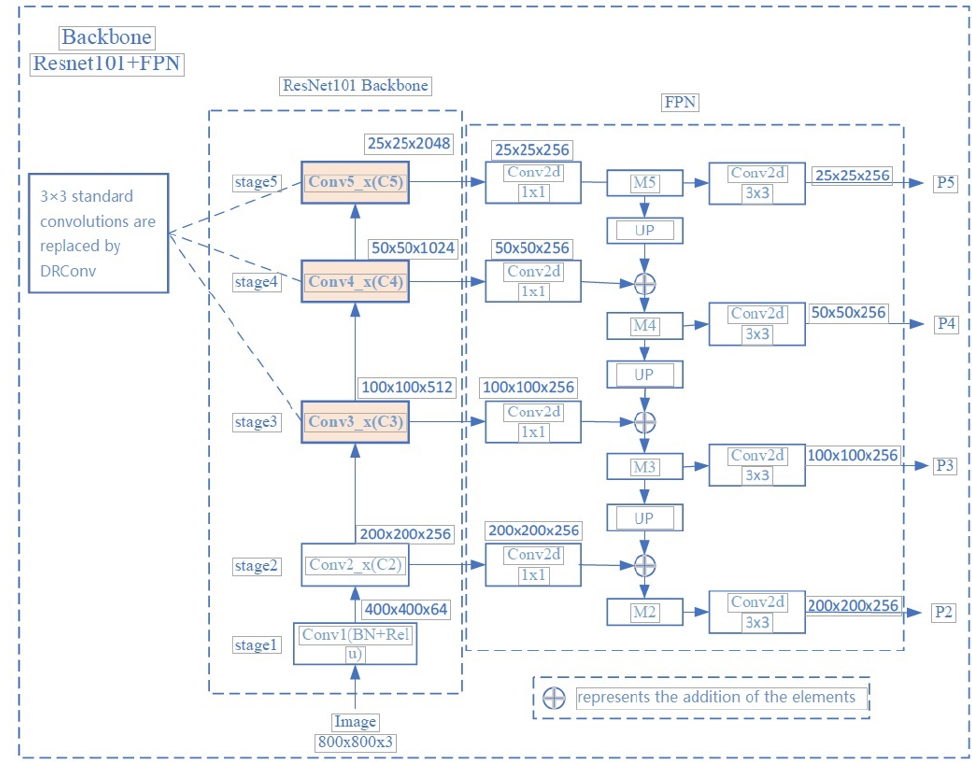
Figure 2. Improved